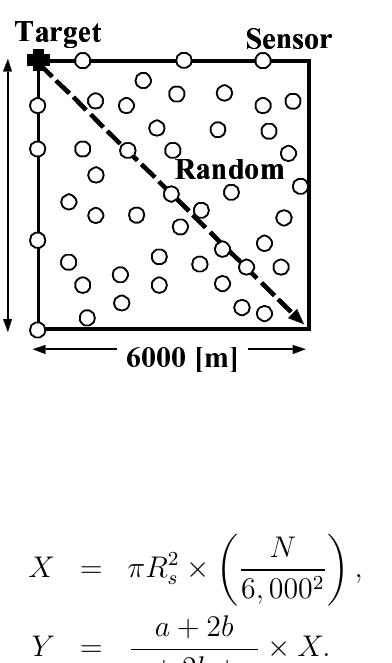
Figure 4. Simulation